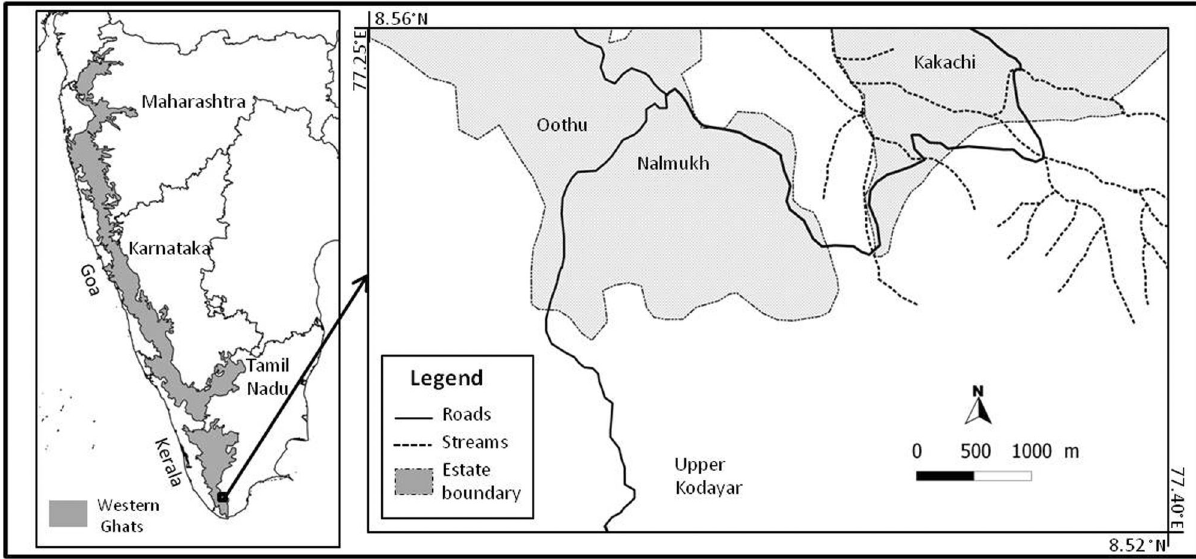
Figure 1. Map of the study site in the Western Ghats, and the Kakachi and Nalmukh tea estates of the Kalakad Mundanthurai Tiger Reserve. In the insert map, white area indicates forests and grey area indicates tea plantations with